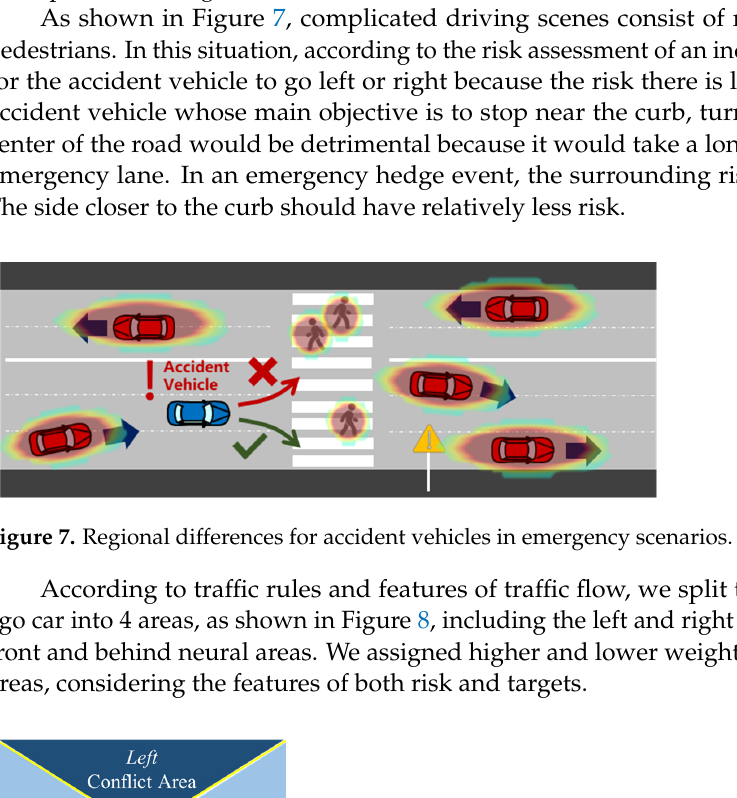
Figure 6. Distribution of target attraction field over time.